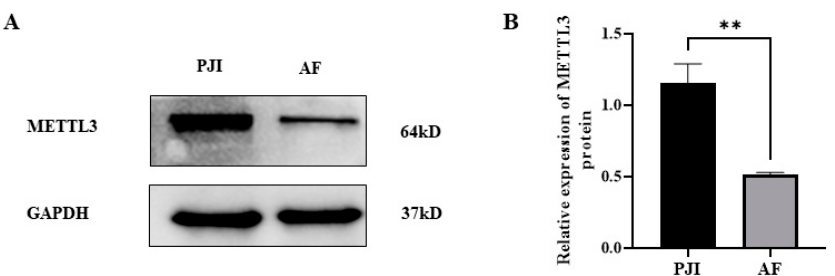
Figure 2. The expression of METTL3 in PJI and AF detected by Western blot ( A ) and statistical analysis ( B ). PJI: periprosthetic joint infection; AF: aseptic failure; ** p < 0.01.